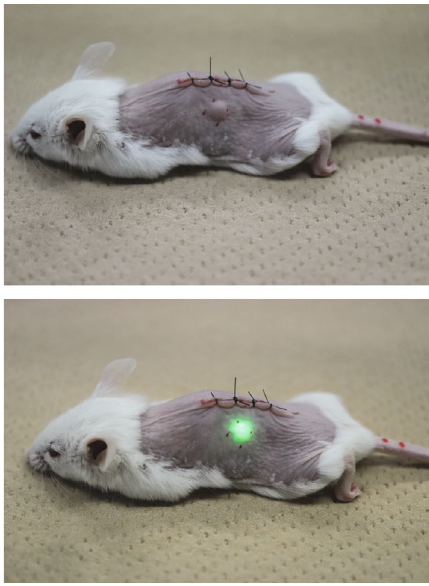
Figure 3. A mouse implanted with a wirelessly powered LED device in subcutaneous tissue just below the intradermal tumor: non-luminescent state (upper) and emitting state